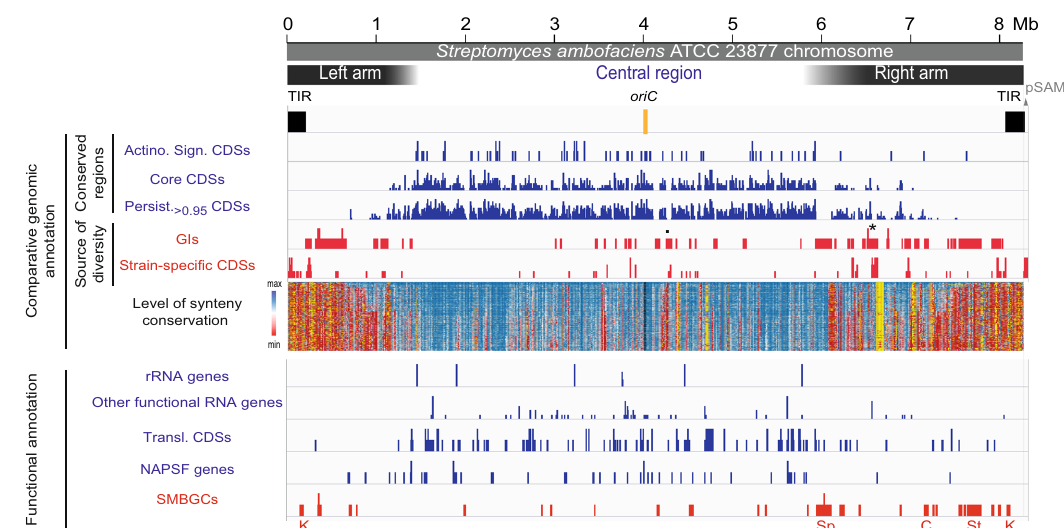
Fig. 1 The genetic compartmentalization of S. ambofaciens linear chromosome. The terminal inverted repeats (TIRs, 200 kb) and the origin of replication ( oriC ) are indicated. The distribution of gene presenting features of interest are represented in blue or red when enriched in the central region or within the extremities (de fi ned by the fi rst and last rDNA operons), respectively (see Supplementary Table 2 for statistical analysis of the data). The dot and asterisk indicate the position of pSAM2 and a complete prophage, respectively. The position of the SMBGCs encoding the biosynthesis of all known antibacterial compounds of S. ambofaciens ATCC 23877 is also indicated. The level of synteny along the chromosome of S. ambofaciens ATCC 23877 is represented as a heat map of gene order conservation (GOC) scores using a sliding window (8 CDSs with 1 CDS step). Each line corresponds to the GOC pro fi le of the reference against another species. The 124 species are organized from the phylogenetically closest to the furthest compared to S. ambofaciens . The vertical black dotted line represents the location of the dnaA gene delineating the two replicators. “ NA ” (in yellow) indicates the absence of orthologs in the corresponding window. S. ambofaciens ATCC 23877 also harbors a circular pSAM1 plasmid ( ≈ 89 kb). Abbreviations : ‘ Actino. Sign. CDSs ’ (coding sequences of the actinobacterial signature); BGC (biosynthetic gene cluster); ‘ C. ’ (congocidine BGC); ‘ Chr. ’ (whole chromosome); GIs (genes belonging to genomic islands); ‘ K. ’ (kinamycin BGC); ‘ Persist .>0.95 CDSs ’ (coding sequences of S. ambofaciens ATCC 23877 presenting a gene persistence superior to 95% in 124 other Streptomyces genomes); ‘ Transl. CDSs ’ (genes encoding functions involved in translation process and/or RNA stability); NAPSFs (nucleoid- associated proteins and structural factors); SMBGCs (specialized metabolite BGCs); ‘ Sp. ’ (spiramycin BGC); ‘ St. ’ (stambomycin BGC); ‘ rRNA ’ (ribosomal RNA).